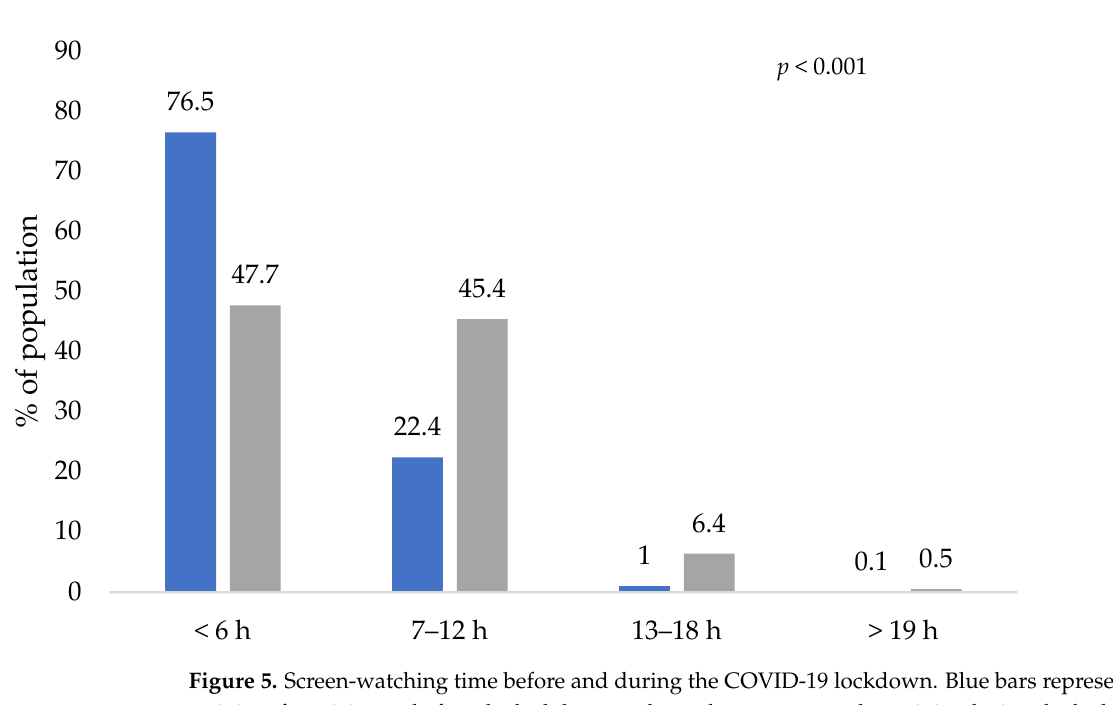
activity of participants before the lockdown and gray bars represent the activity during the lock- The p -values indicate the statistical significance of the McNemar test.